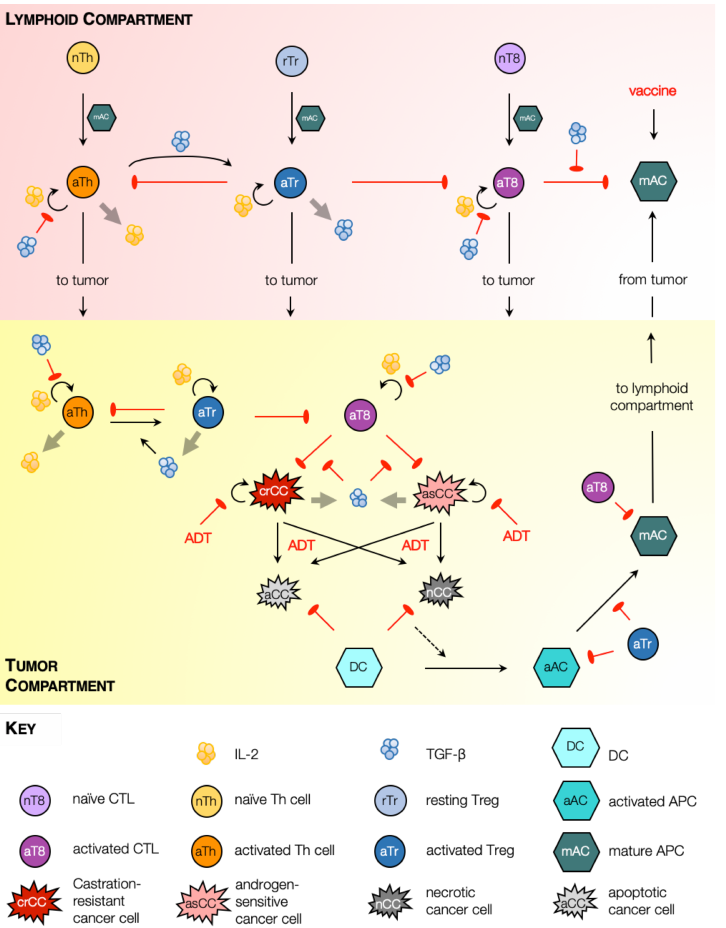
Figure 1. Model schematic. Solid black arrows indicate transformation of one species to another, or transport of species. Semi-circular black arrows indicate proliferation. Red arrows with flat heads indicate inhibition or cell kill. Light grey arrows indicate expression of